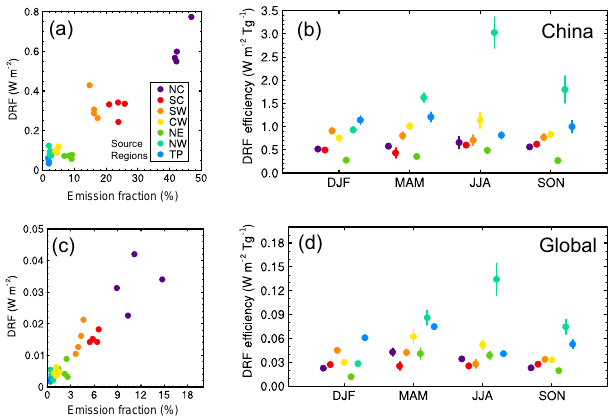
Figure 12. (a, c) BC seasonal DRF averaged over China as a func- tion of BC emission fraction (the ratio of regional emission to the to- tal emission over China and globally; unit: %) for each of the tagged regions. (b, d) Seasonal DRF efficiency of BC (Wm − 2 Tg − 1 ) for each of the tagged source regions over China and globally, respec- tively. The efficiency is defined as the DRF divided by the corre- sponding scaled annual emission (seasonal emission multiplied by 4). Error bars indicate 1 σ of mean values during 2010–2014.